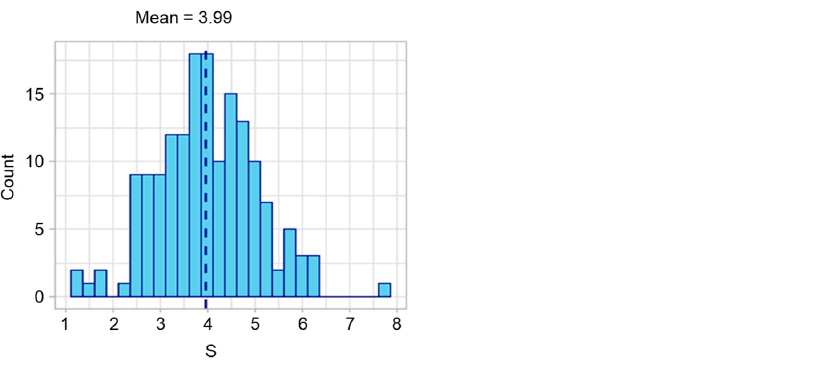
Figure 3. Study design of ROC analysis for HCC onset within X years. Figure 4. Results from the ROC analysis. ROC for the case of discriminating between patients who would develop HCC within 1 year and those who would develop HCC later or not ( a ). ROC for the case of discriminating between patients who would develop HCC within 3 years and those who would develop HCC later or not ( b ). AUC, sensitivity, and specificity obtained from the ROC